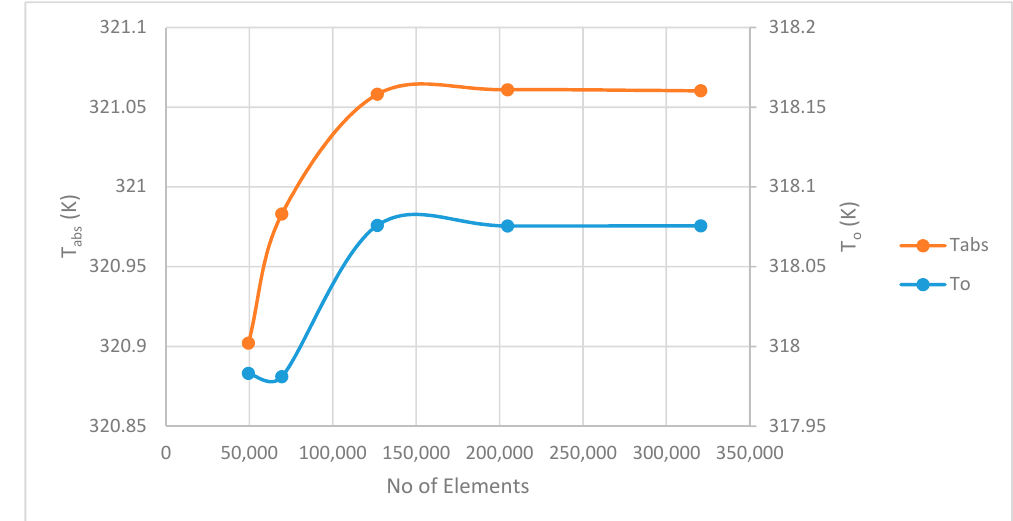
Figure 3. Grid independent study for the FPC computational domain.